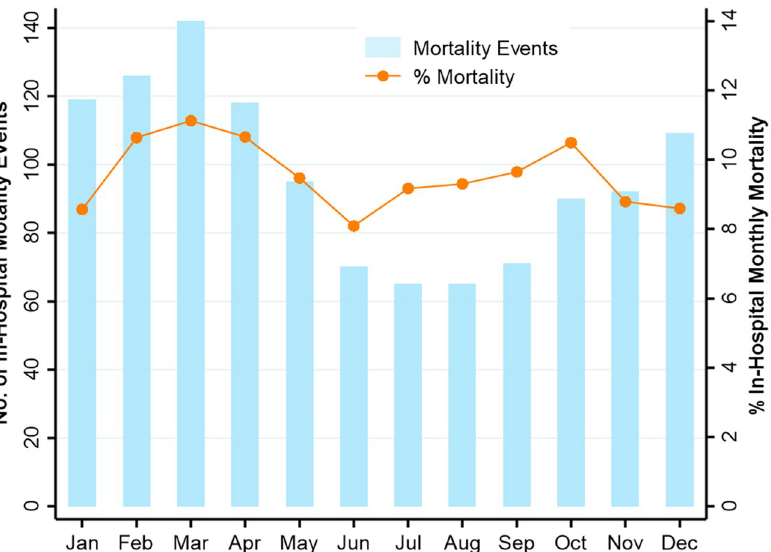
Figure 5. Counts of in-hospital mortality events (blue bars) and the proportion of mortality (orange dots) in each